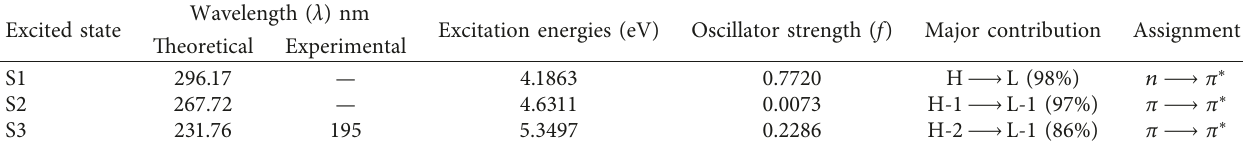
Table 6: BDSC electronic absorption spectrum values, both experimental and theoretical.